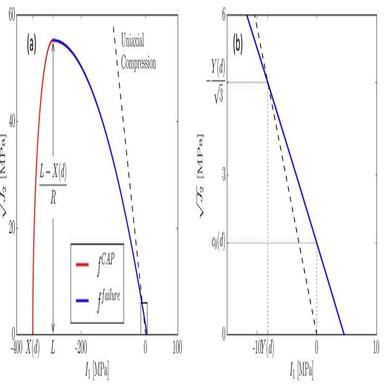
(a) Visualization of the yield surface for the used material model developed by Brandt and Nilsson . (b) Magnified view of the marked area in (a) showing the region around I1= 0. The relative density d = 0.55.